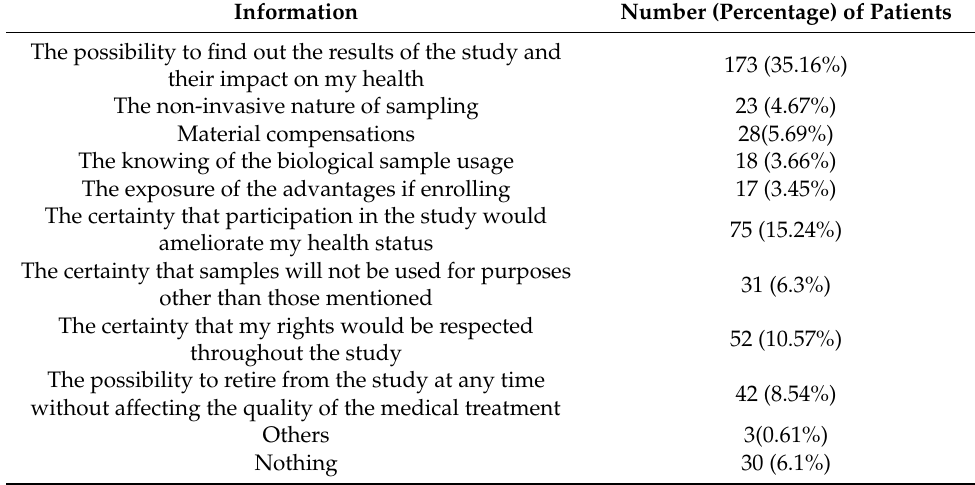
Table 3. Important information to convince the respondent to participate in a biomarker study (Choose one or two options).